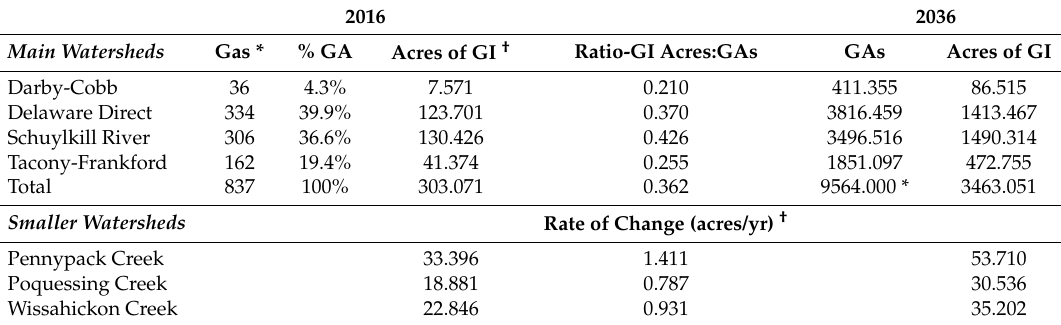
Table 4. Resulting calculations for the increase in GI by 2036 (1 acre = 4046.86 m 2 ).